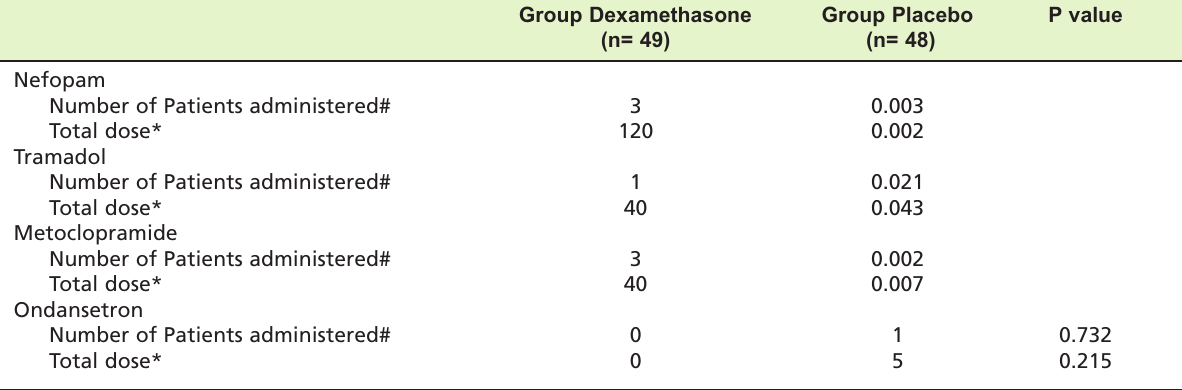
Rescue medication and antiemetic drug administration in two groups Table III: Group Dexamethasone